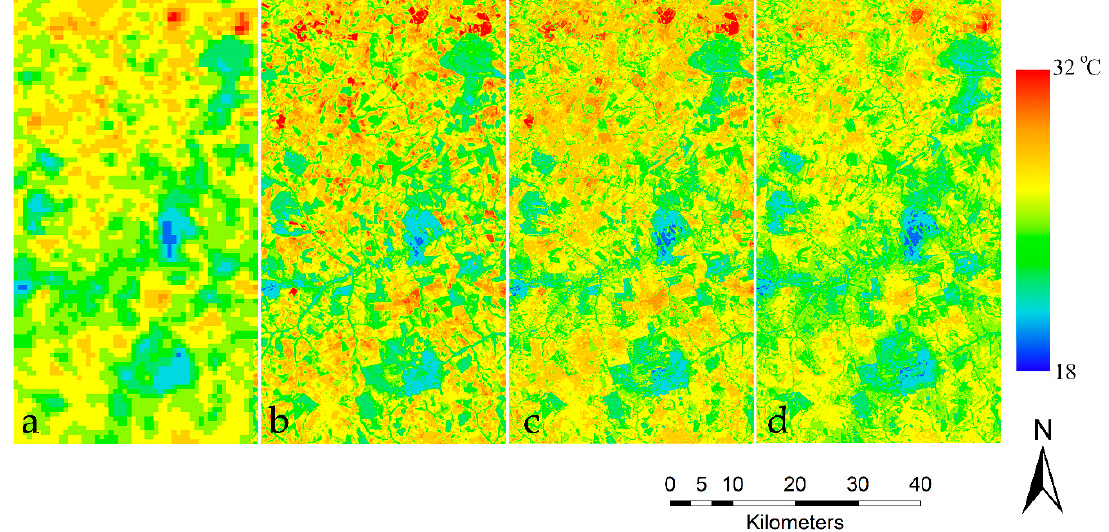
Figure 5. Sharpening brightness temperature images from a 960-m to a 60-m resolution for Site 1. ( a ) Sentinel-3 BT at 960 m. ( b ) Reference Landsat 8 BT at 60 m. ( c ) Sharpened to 60-m BT derived from applying TsHARP to aggregated Landsat 8 using Landsat 8 60-m Normalized Difference Vegetation Index (NDVI). ( d ) Sharpened to 60-m BT derived from applying TsHARP to Sentinel-3 using Sentinel-2 60-m NDVI.